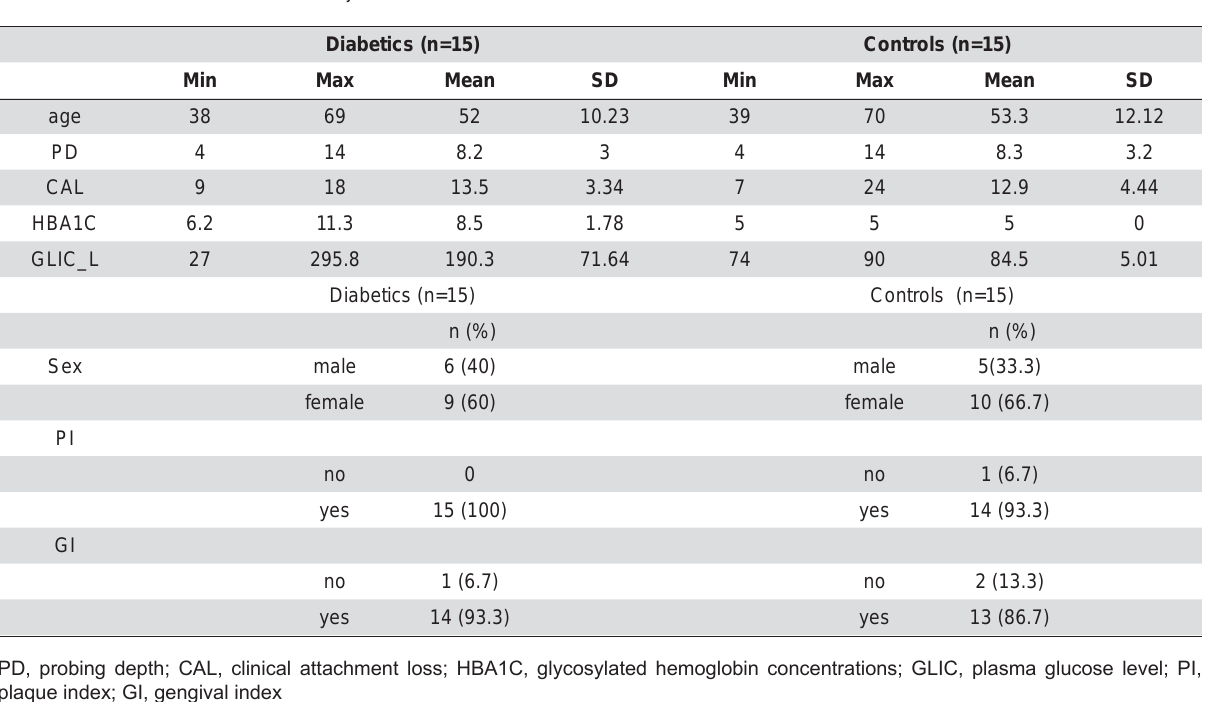
Table 1- Main characteristics of the subjects studied